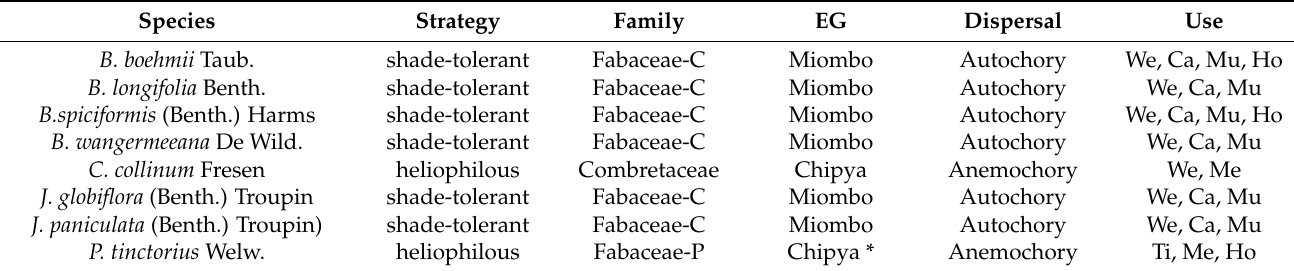
Table 2. Characteristics of tree species used as seed sources for planting. Species Use